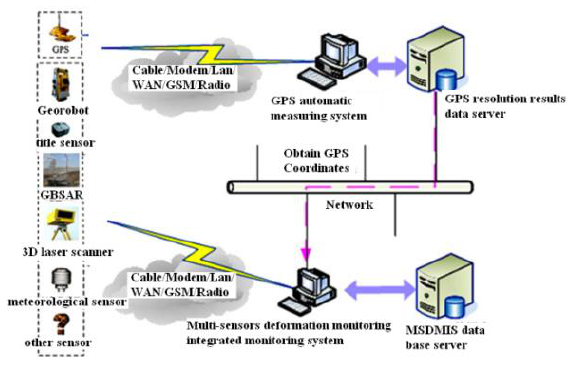
Figure 8. Geosensor Network